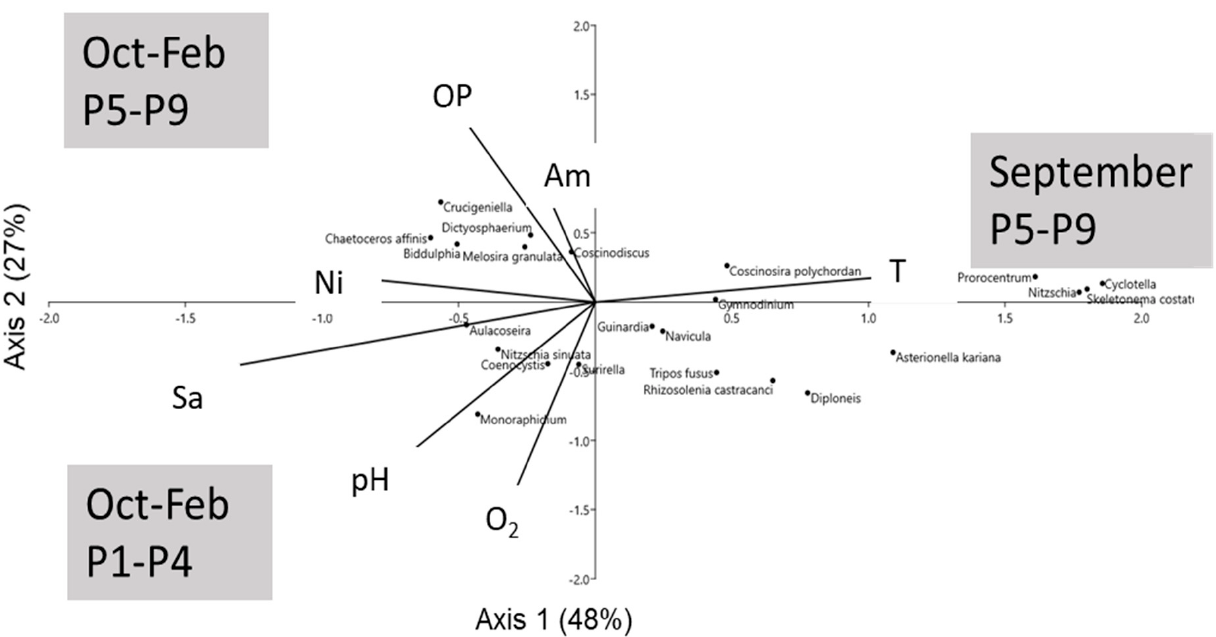
Figure 11. CCA of samples, limnological variables and taxa obtained in Salinas Grandes. Explained variance is shown in each axis. Abbreviations as in Figure 5. Ordination by CCA of EPR data was not significant ( p < 0.001).